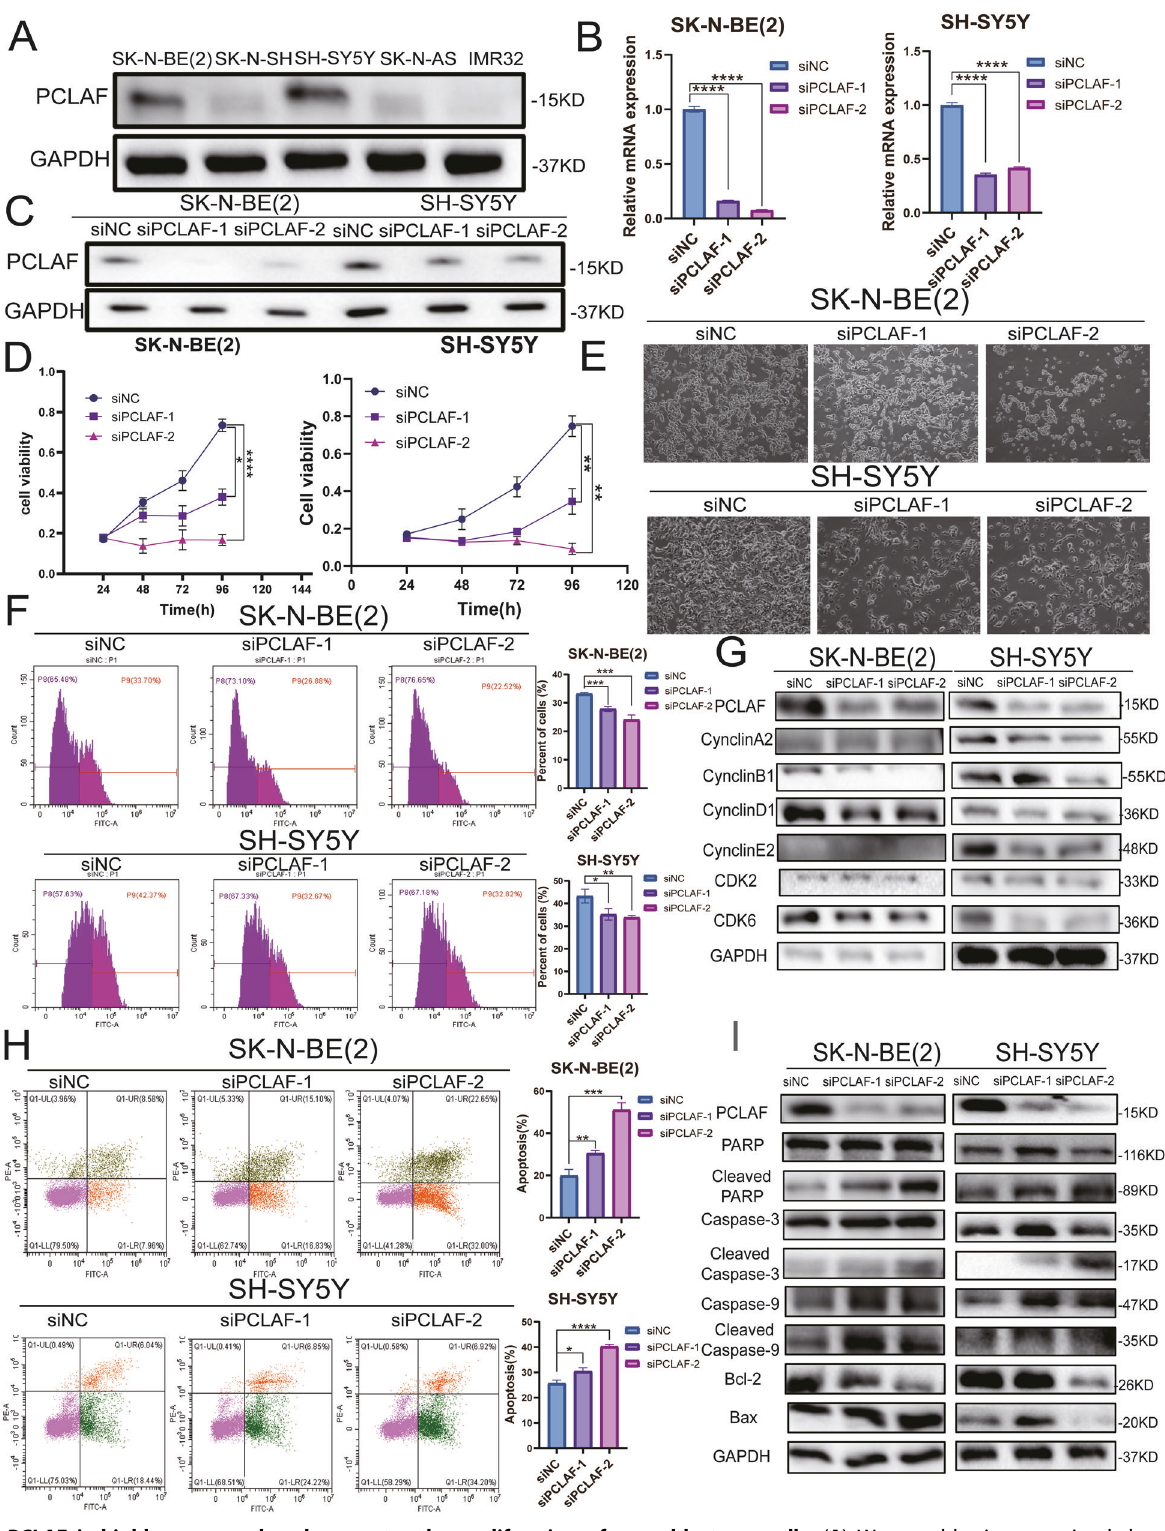
Fig. 2 PCLAF is highly expressed and promotes the proliferation of neuroblastoma cells. ( A ) Western blotting examined the protein expression of PCLAF in 5 neuroblastoma cell lines; ( B, C ) Interference ef fi ciency of 2 small interfering RNAs with different sequences on PCLAF in SK-N-BE (2) and SH-SY5Y cell lines, detected by qRT-PCR and Western blotting; ( D ) The in vitro proliferation function of PCLAF was evaluated by CCK-8; ( E ) SK-N-BE(2) and SH-SY5Y cell lines with PCLAF siRNA performed imaging analysis after 48 h; ( F ) The in vitro proliferation function of PCLAF was evaluated by fl ow cytometry EdU labeling detection; ( G ) Western blotting was used to detect cell proliferation-related proteins; ( H ) PCLAF knockdown led to cell apoptosis in a fl ow cytometric apoptosis assay; ( I ) Apoptosis related markers were detected by western blot in neuroblastoma cells. (* p < 0.05, ** p < 0.01, *** p < 0.001and **** p < 0.0001, and bar graphs represent the mean ± SEM).